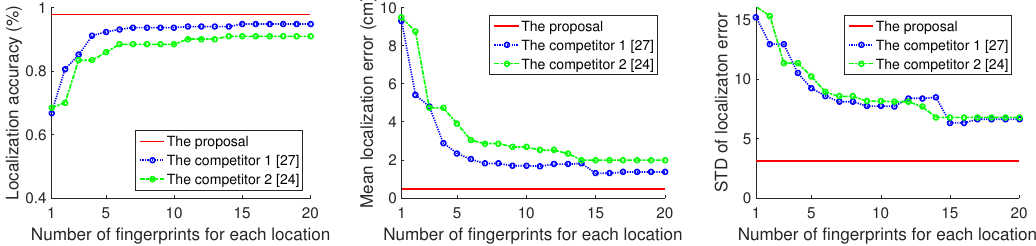
Figure 14. Comparison of localization